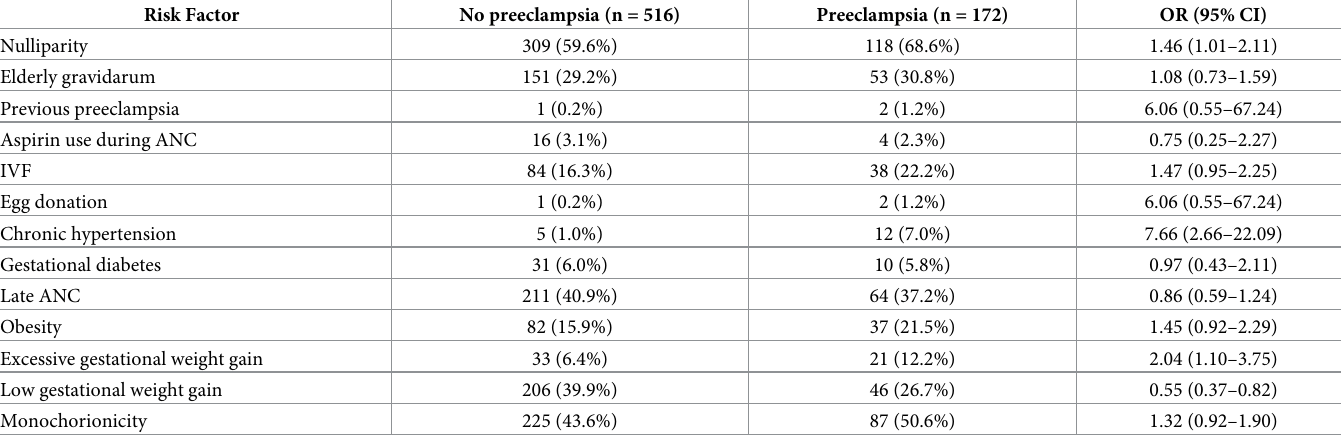
Table 2. Risk factors for preeclampsia in twin pregnancies from univariate analysis.